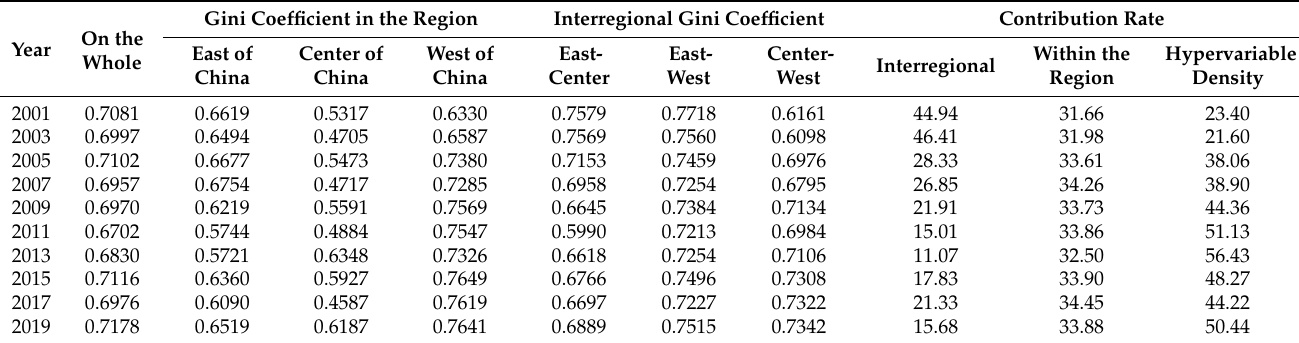
Table 6. Gini coefficient of the animal husbandry water environment bearing pressure in China and its decomposition results. Gini Coefficient in the On the Year Whole